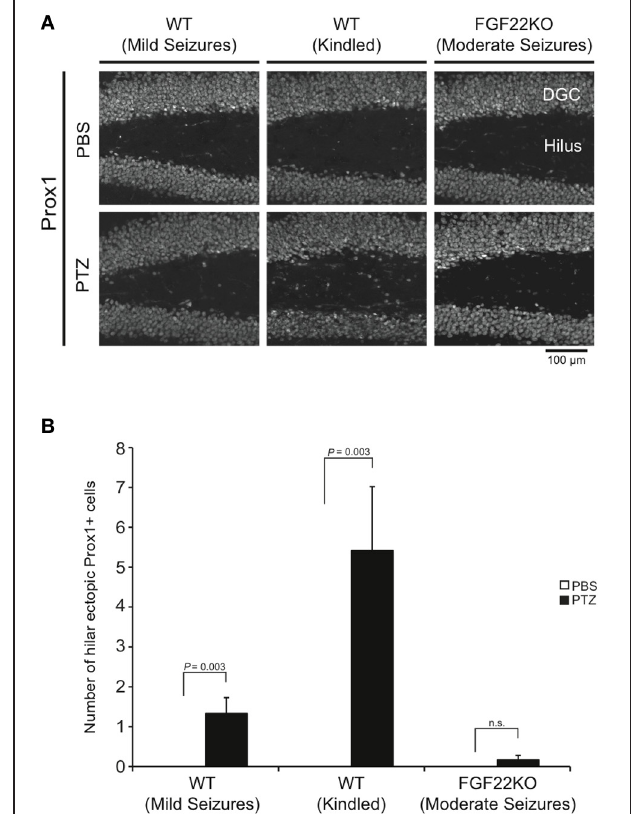
FIGURE 4 | The number of hilar ectopic DGCs is increased in WT mice with mild and kindled seizures, but not in FGF22KO mice with moderate seizures. Region-matched sagittal hippocampal sections were prepared from PBS- and PTZ-injected WT and FGF22KO mice (3 groups of mice as shown in Figure 1 ) and stained for Prox1, a marker for DGCs. Ectopic location was defined as greater than or equal to two cell body widths outside the granule cell layer. (A) Prox1 positive cells in the DG and hilus of PBS- or PTZ-injected mice. (B) Quantification of the numbers of ectopic Prox1-positive cells in the hilus. The number of hilar ectopic DGCs was significantly increased in WT mice with mild and kindled seizures, but not in FGF22KO mice with moderate seizures upon PTZ-injections. Bars are mean ± s.e.m. Student’s t -test P -values are